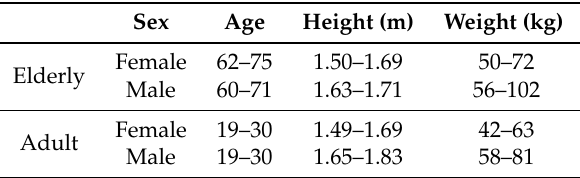
Table 3. Age, height and weight of the participants.